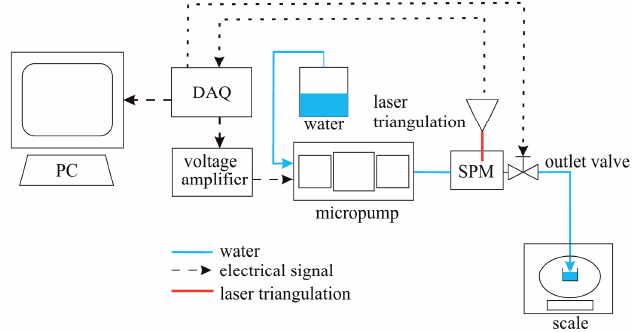
Figure 11. Measurement setup for the drug delivery system. The outlet valve can be opened on demand. The pump can stop at any time depending on the displacement, measured by the laser